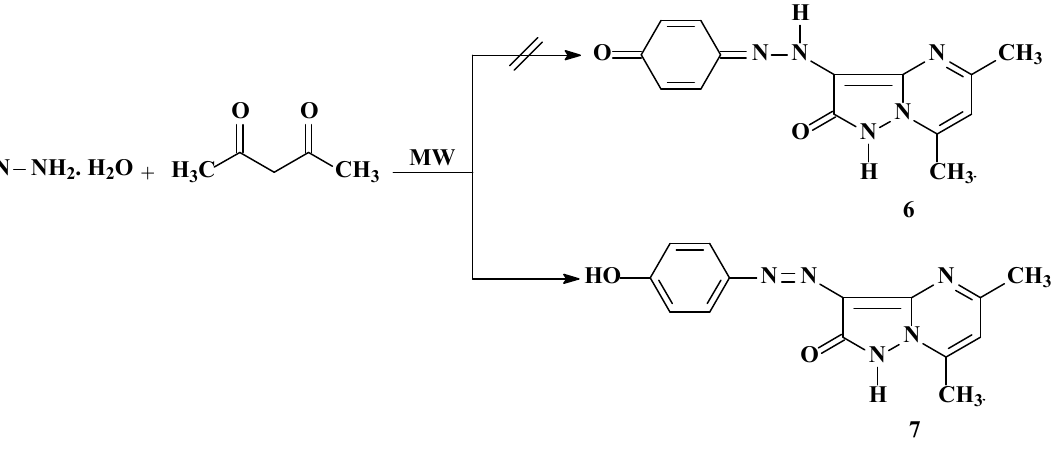
Figure 2. Ortep plot of the X-ray crystallographic structure of 7